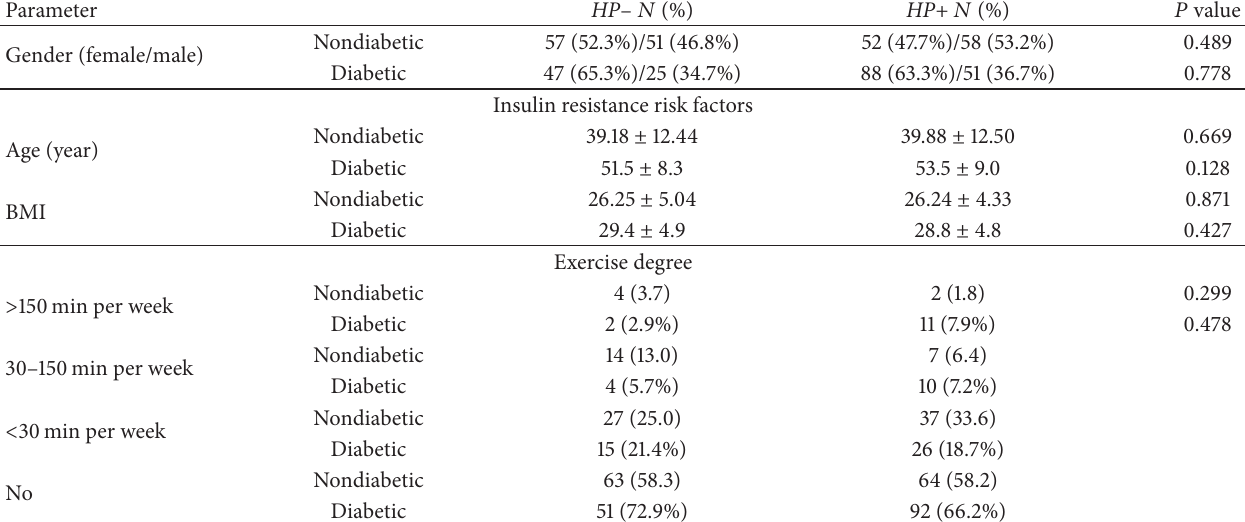
Table 1: The characteristics of the patients with respect to seropositivity for HP